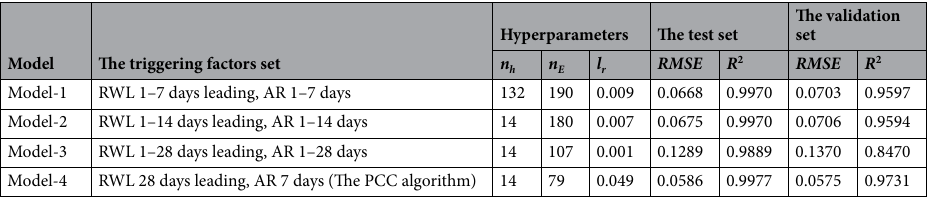
Table 3. The prediction accuracy comparisons between different triggering factors of the GWO-LSTM model.